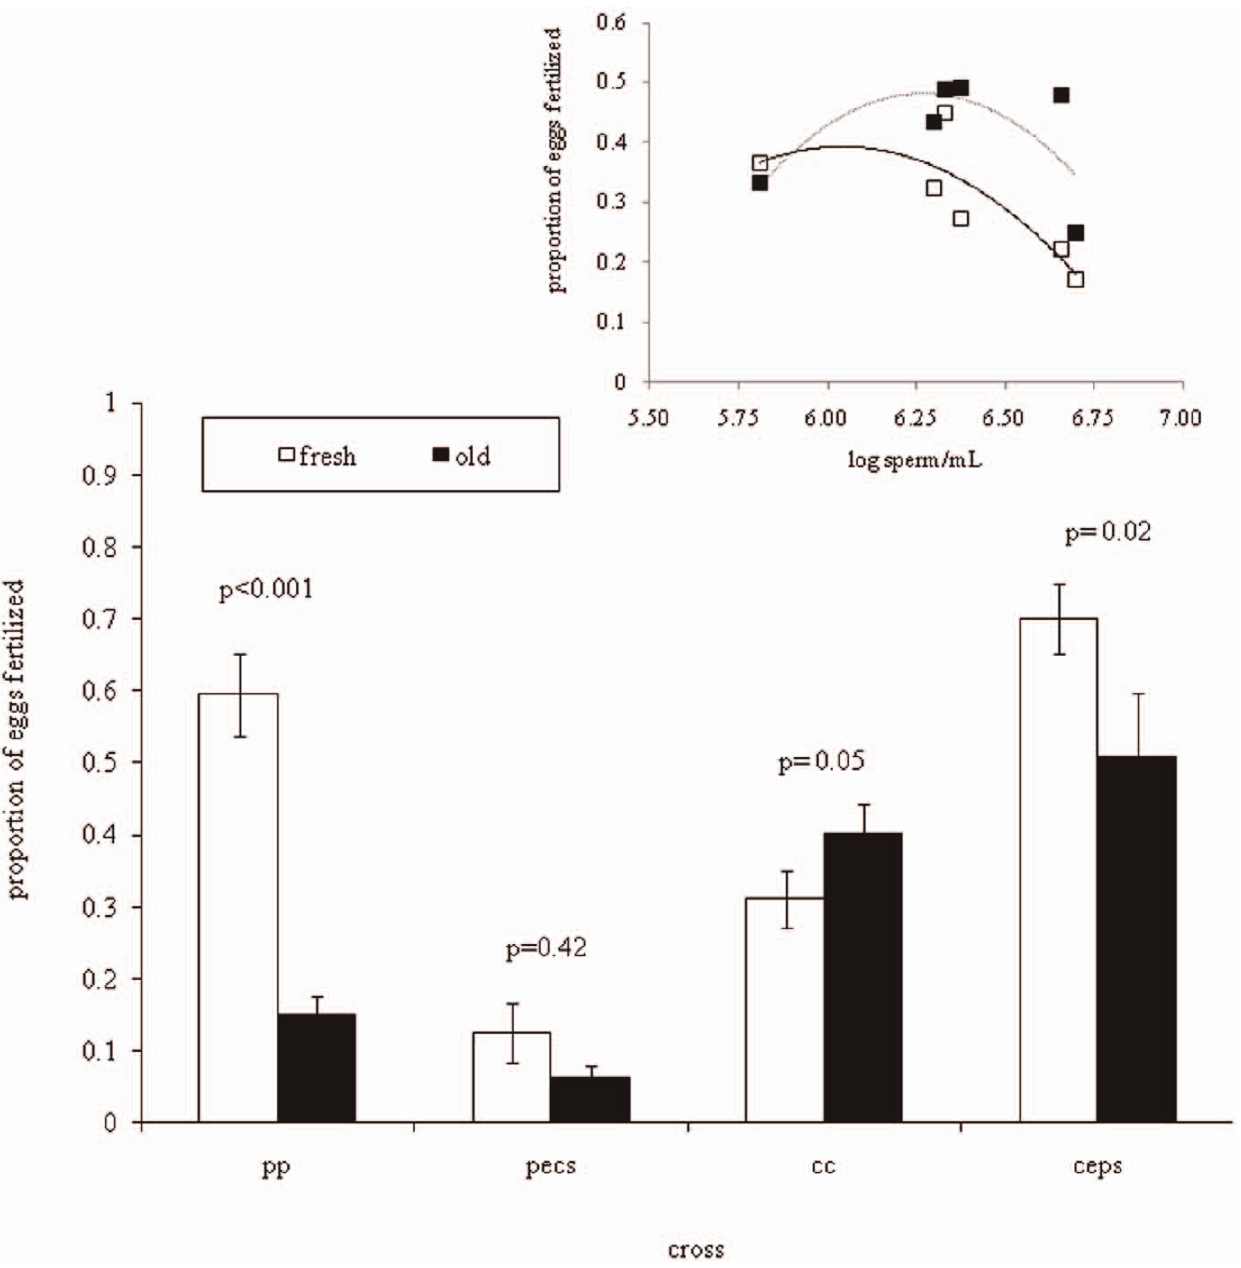
Figure 4. The effect of gamete aging on no-choice fertilization crosses. Open bars denote fresh gametes (30 minutes after bundle breakup) and shaded bars denote aged gametes (4–5 hours). Double letters represent conspecific crosses (p= A. palmata and c= A. cervicornis ) and these letters followed by an ‘‘e’’ or ‘‘s’’ represent eggs or sperm for each heterospecific cross. Numbers above bars represent p-values and error bars represent standard error. The inlay represents the individual no-choice crosses for conspecific A. cervicornis fertilization trials, suggesting that a decrease in fertilization at high sperm concentrations (possibly a result of polyspermy) may be biasing the result of lower fertilization when gametes were fresh.